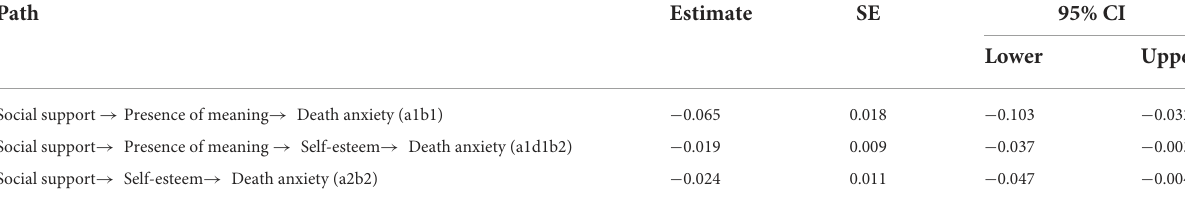
TABLE 4 The standardized indirect effect in the model of social support and death anxiety, mediated by presence of meaning, and self-esteem. Path